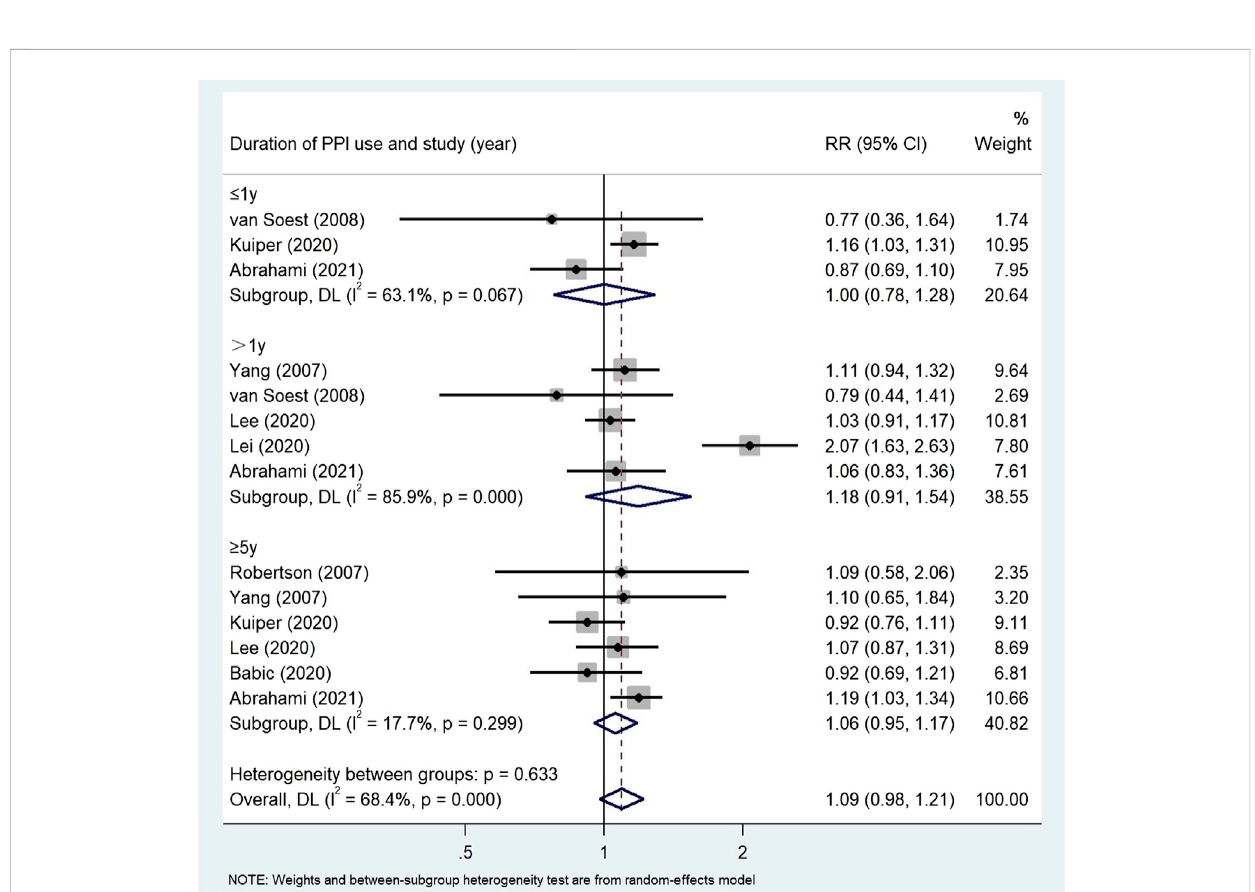
FIGURE 7 Association between the use of PPI and risks of Colorectal Cancer strati fi ed by duration of PPI.